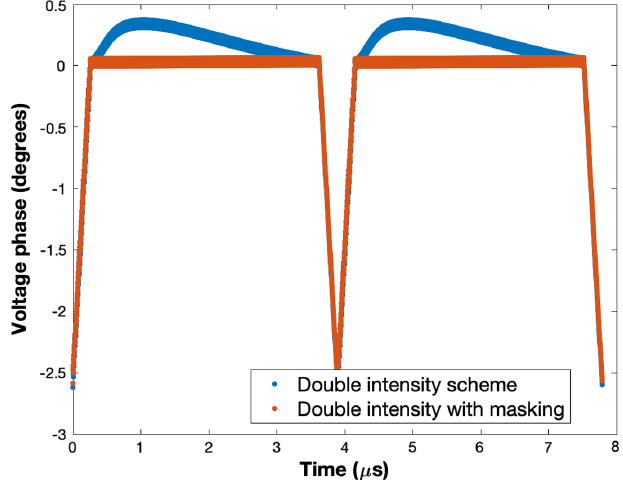
FIG. 14. Cavity phase voltage with and without error signal masking.